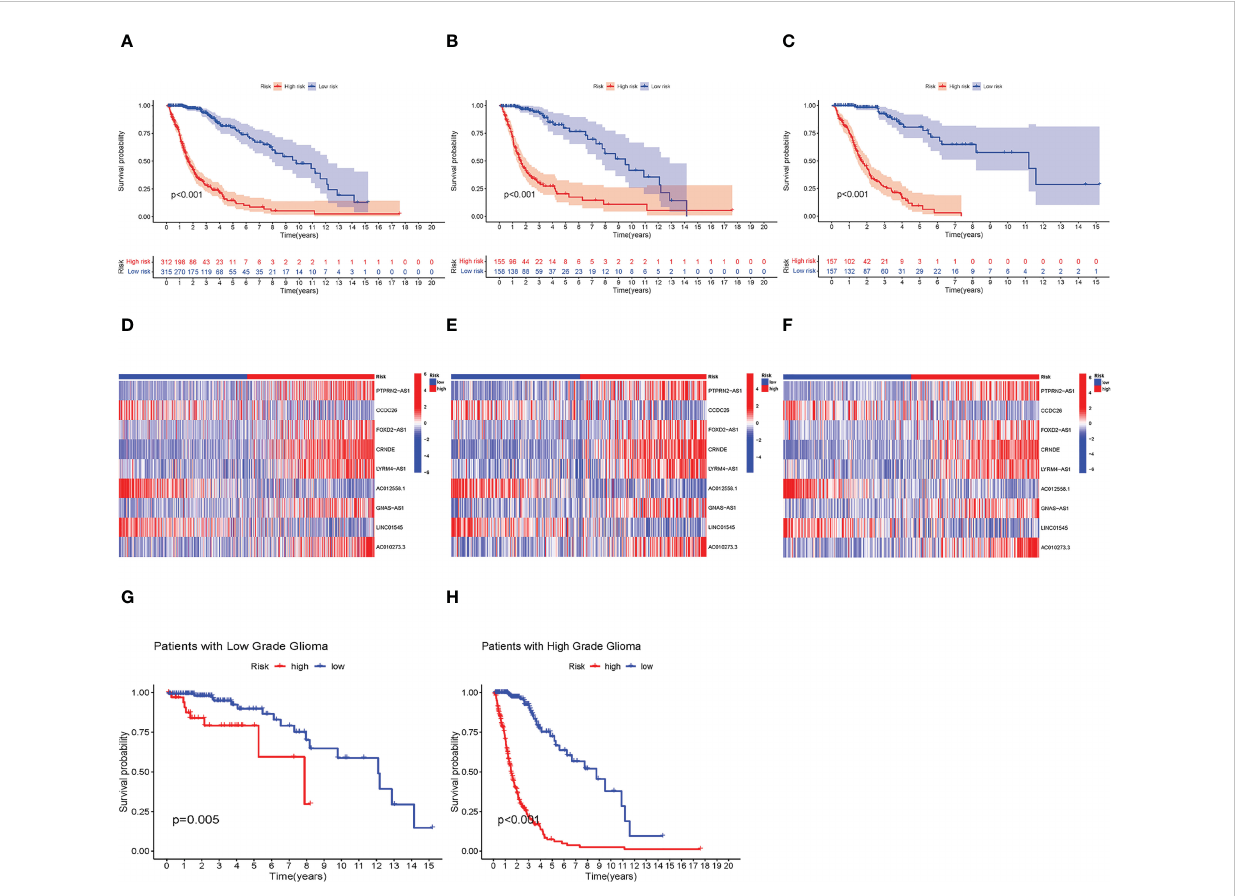
FIGURE 2 Veri fi cation of the prognostic model. (A – C) Kaplan – Meier (KM) survival curves of entire, test, and train groups, respectively. (D – F) The expression difference of 9 necroptosis-related lncRNAs between low- and high-risk groups in the entire test, and train group, respectively. (G, H) The KM survival curves of low- and high-grade Glioma, respectively. Construction of Nomogram and Assessment of the Prognosis